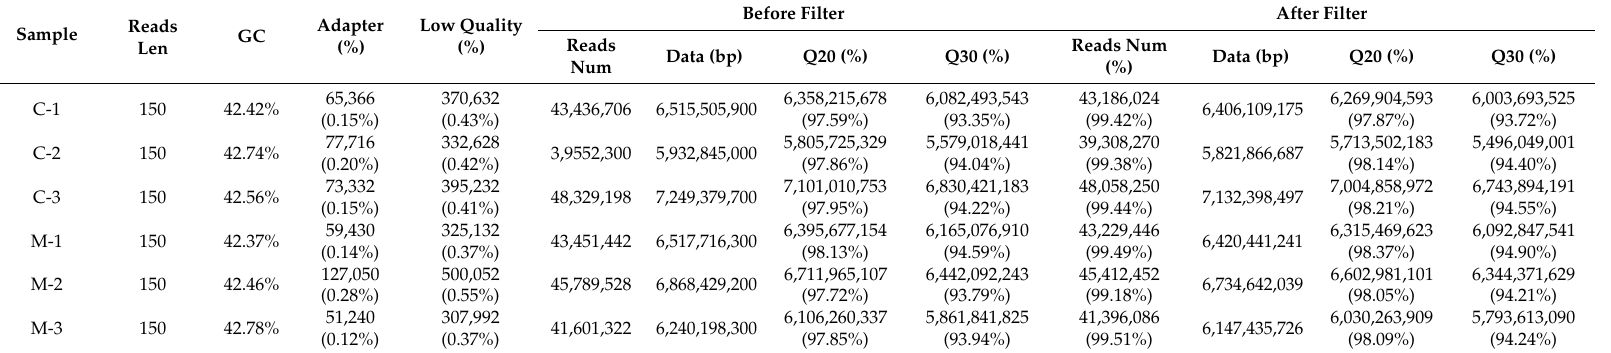
Table 1. Summary of the sequencing quality of six